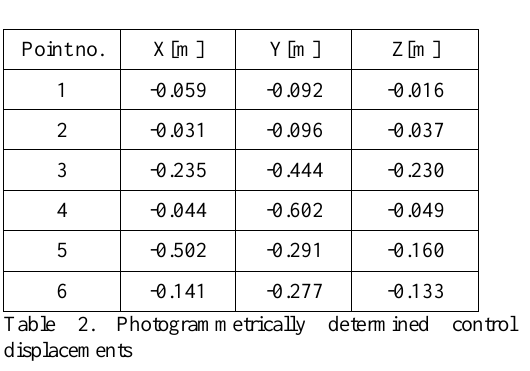
Table 2. Photogrammetrically determined control point displacements Point no.